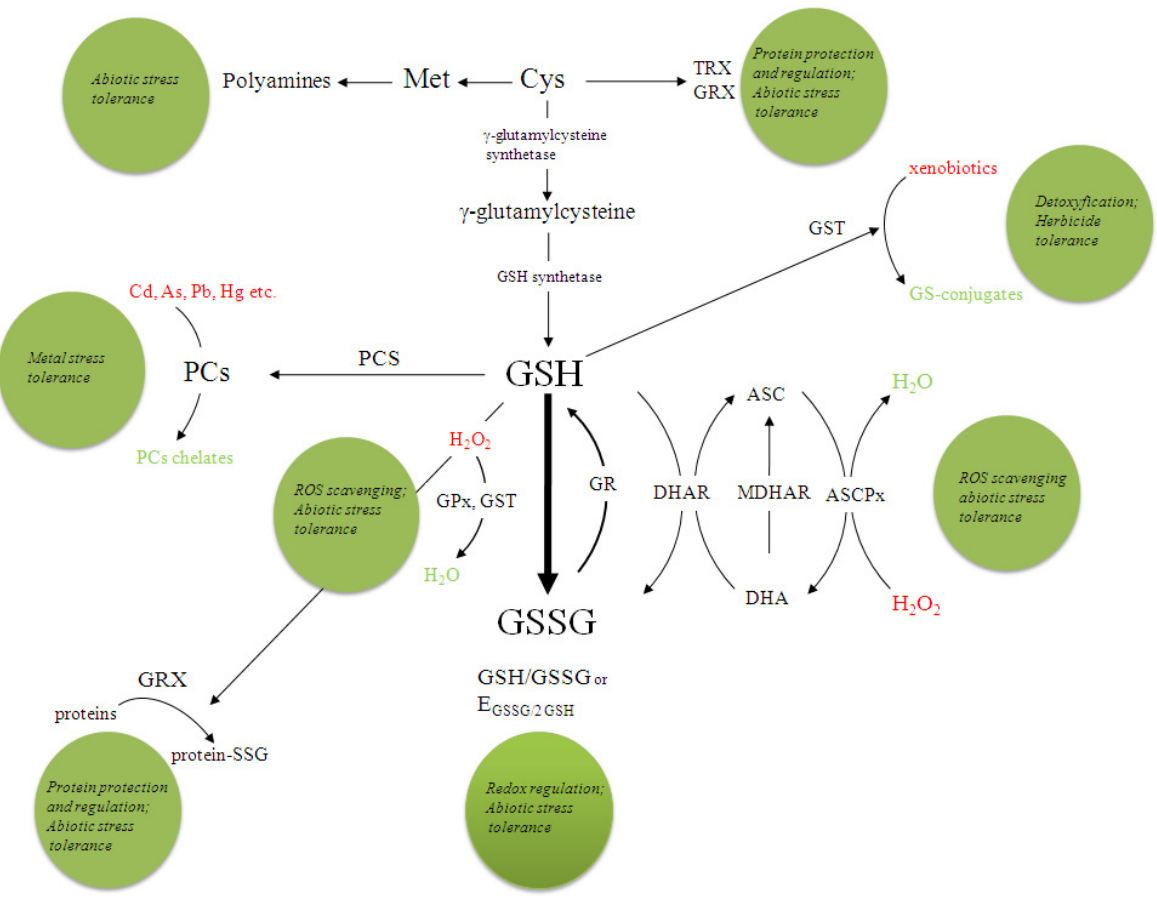
Figure 1. Overview of the roles of thiols in plant tolerance to abiotic stress. Potential roles of and the significance for abiotic stress tolerance are depicted by green circles next to SH-adducts. Potential deleterious compounds are shown in red and their adducts in green font. The dotted circle represents the half-cell reduction potential of the glutathione disulphide (GSSG)/2 glutathione (GSH) redox couple. Met, methionine; Cys, cysteine; TRX, thioredoxin; GRX, glutaredoxin; PC, phytochelatins; PCS, phytochelatin synthetase; GST, glutathione-S-transferase; GPx, glutathione peroxidase; GR, glutathione reductase; DHAR, dehydroascorbate reductase; ASC, ascorbate; MDHAR, monodehydroascorbate reductase; DHA, dehydroascorbate; ASCPx, ascorbate